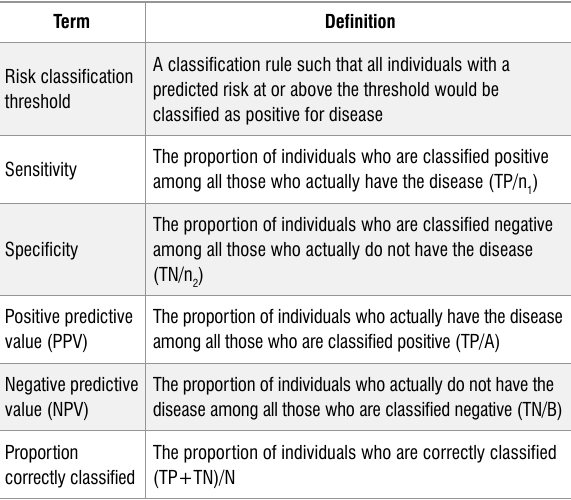
Potential predictors of silicosis diagnosis Predictor variable Description